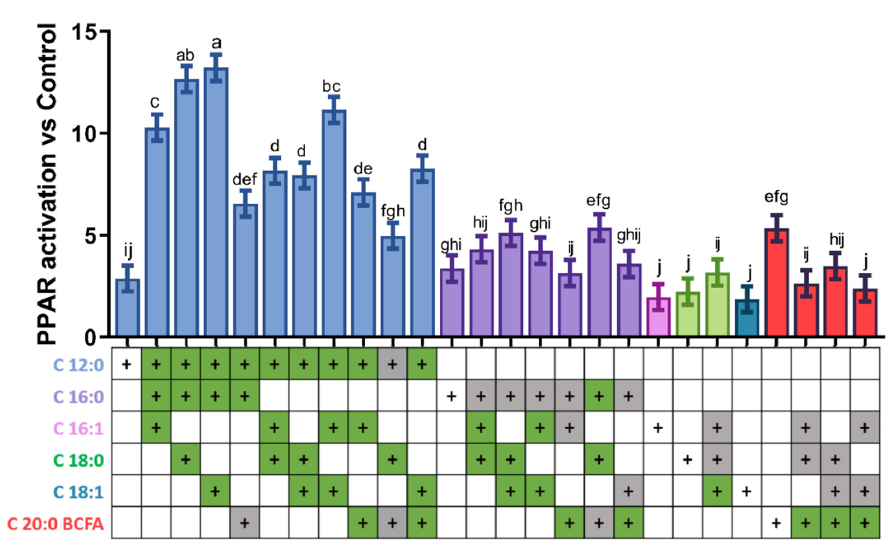
Figure 3. PPAR activation by combinations of three fatty acids. Compound doses are: C12:0, 167; C16:0, 53; C16:1, 53; C18:0, 63; C18:1, 53; C20:0 BCFA, 53 μ M. Dissimilar letters above bars refer to statistically significant ( p < 0.05) difference between each treatment when all pairwise comparisons are considered; green cells below the graph indicate significant differences ( p < 0.05) in PPAR activation between the mixture and the individual fatty acid within the mixture reported on the left, when considering pairwise comparisons between the various mixture containing the fatty acid and the individual fatty acid, while gray cells indicate no significant differences ( p >